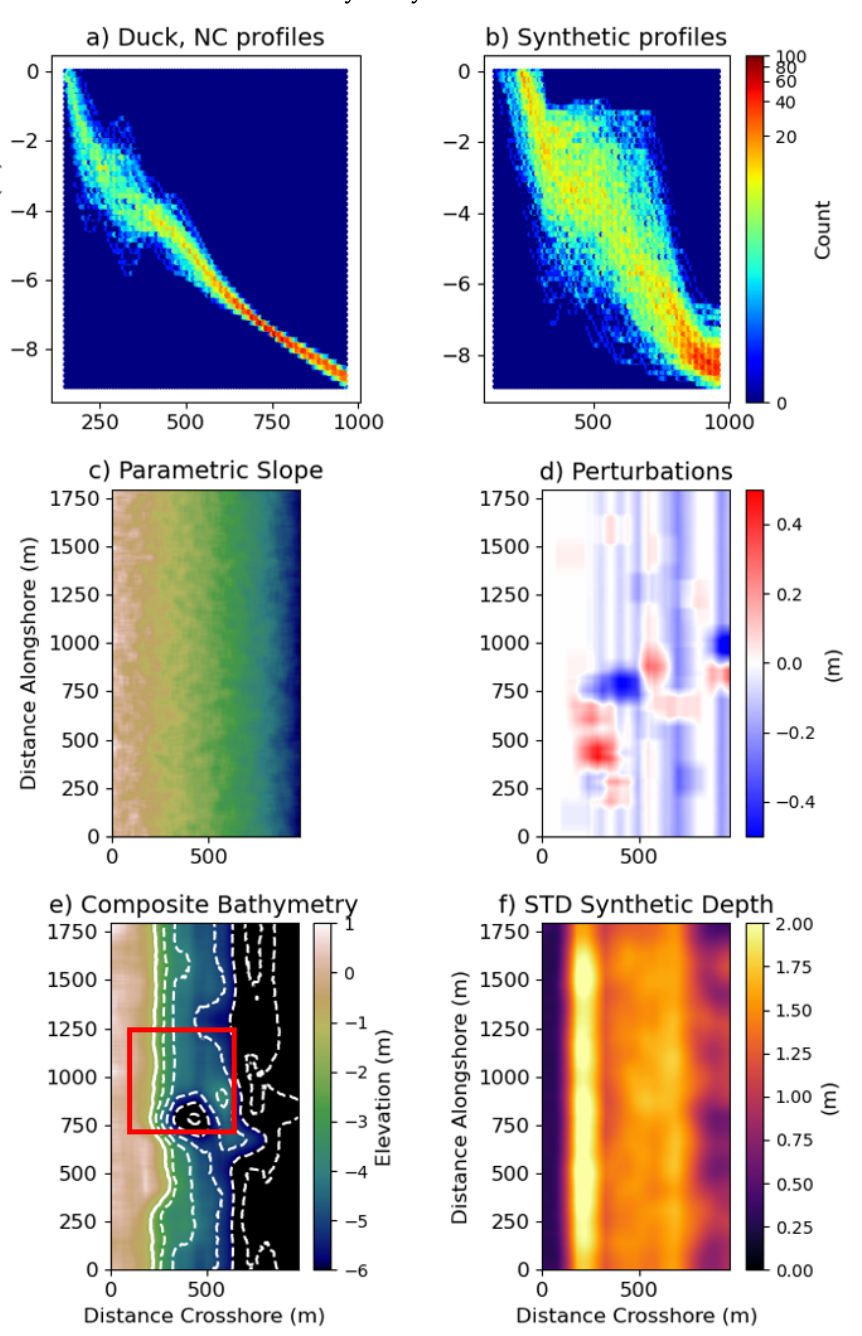
Figure 3. A step through the logic of the bathymetry selection. ( a ) Along-shore averaged profiles of the Duck, NC, based bathymetries. ( b ) Along-shore averaged profiles of the synthetically generated bathymetries. ( c – e ) Steps to generate the profiles shown in ( b ). Specifically: ( c ) Example parametric slope. ( d ) Perturbations that are added to the parametric slope. ( e ) Composite bathymetry; the red box shows an example area to be used for training/testing; dashed white contours show 1-m increments with z = 0 shown as a thick white line). ( f ) The standard deviations of the depths of the synthetic bathymetries averaged over the entire training/testing